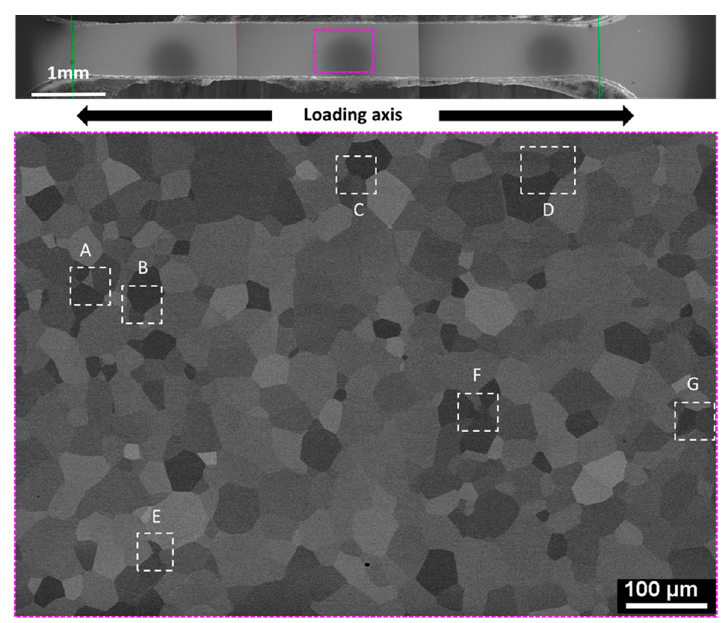
Figure 4. Observed area of 600 × 450 µm² with the seven zones of interest in white dashed frames.